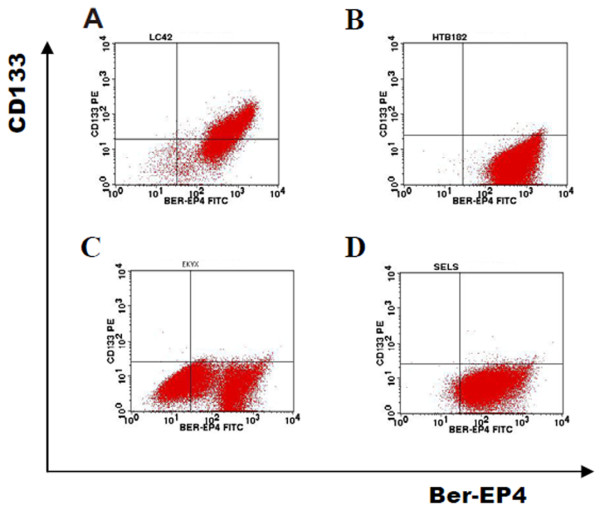
FACS analysis of CD133 antigen expression in the 4 different lung cancer cell lines. One representative experiment of the FACS analysis of CD133 antigen expression in the 4 different lung cancer cell lines: LC-42, HTB-182, EKVX and SELS. CD133 antigen expression was found to be strong in the cell line LC-42 (56.89±6.26%, n= 5), while were weakly expressed on the remaining cell lines and were similar to the isotype control. The pan-epithelia marker Ber-EP4 was widely homogenous expressed in all the cell lines except EKVX.